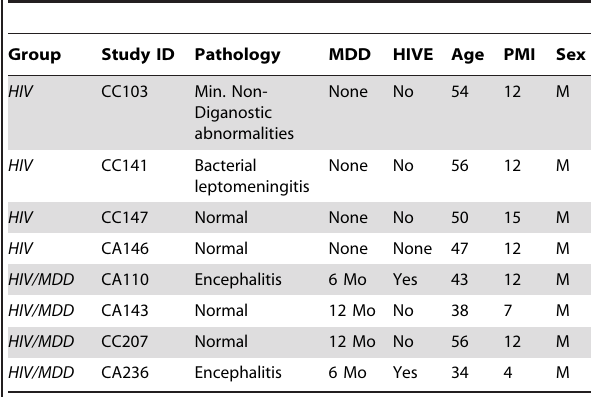
Table 2. Characteristics of Cases in Affymetrix Microarray